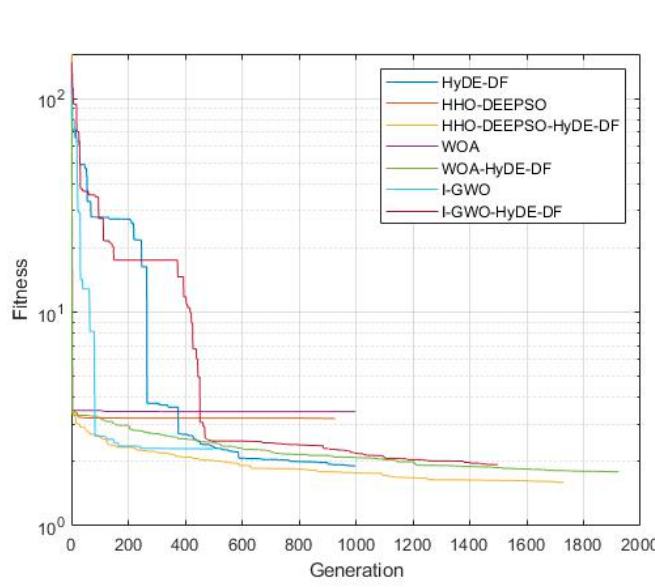
Table 5. Some tuning combinations (cid:1) (HyDE ‐ DF iterations necessary to complete 10,000 fitness func ‐ tion evaluations).